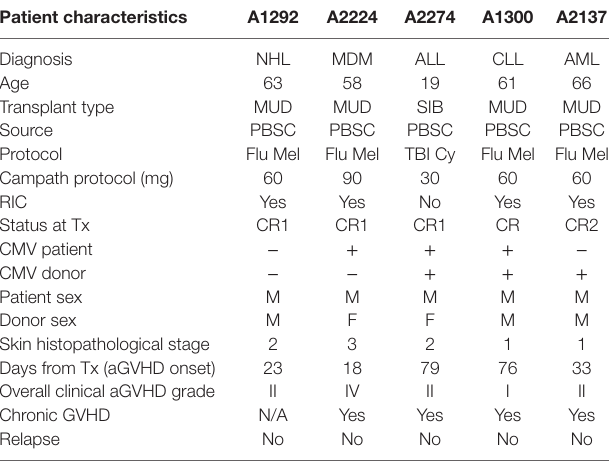
Table 1 | Patient characteristics for the discovery cohort global microRNA skin profiling analysis. Patient